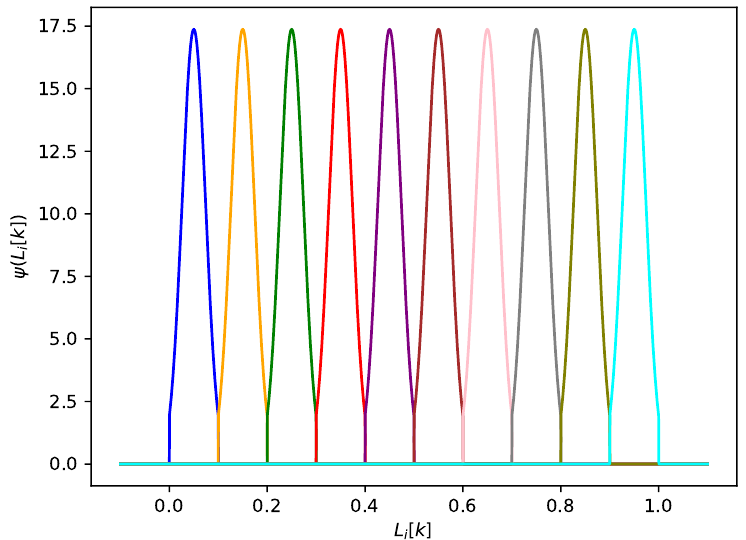
Figure 3. Probability distribution function of 10 agents’